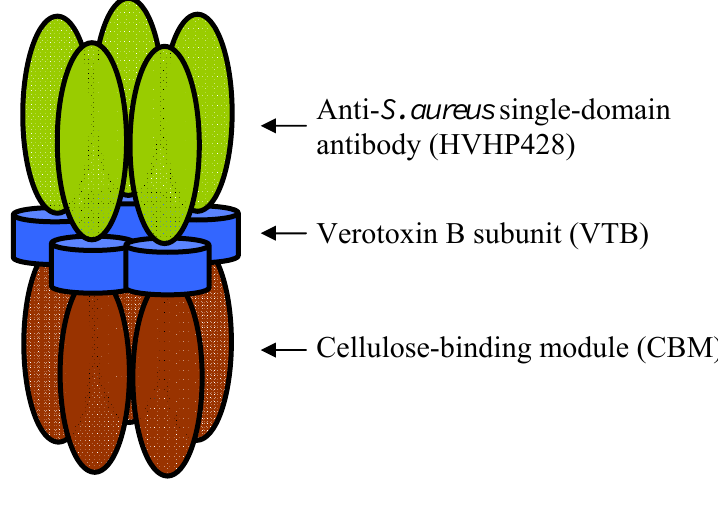
Figure 2. Assembly of bispecific pentamers. (A) Schematic representation of a bispecific pentamer displaying five human sdAbs fused to five CBMs through the verotoxin subunit (VTB). (B-D) Schematic representation of the coding sequences assembled and expressed in pVT1 (B, C) or pPICZ α A